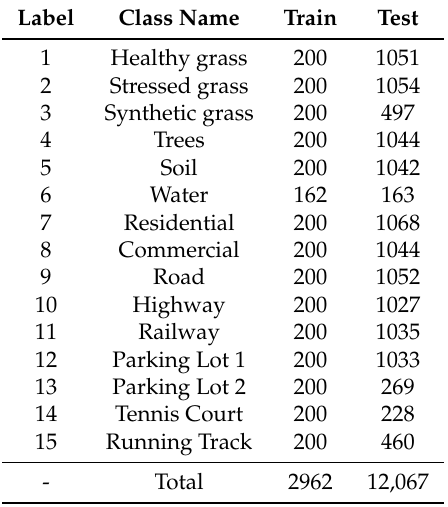
Table 3. The distribution of training and testing samples of the Grss_dfc_2013 data set.